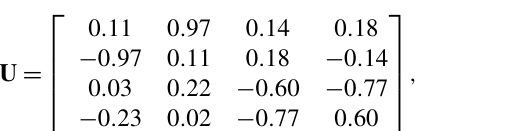
Table 1. Expected variance of wind state estimates based on the a priori